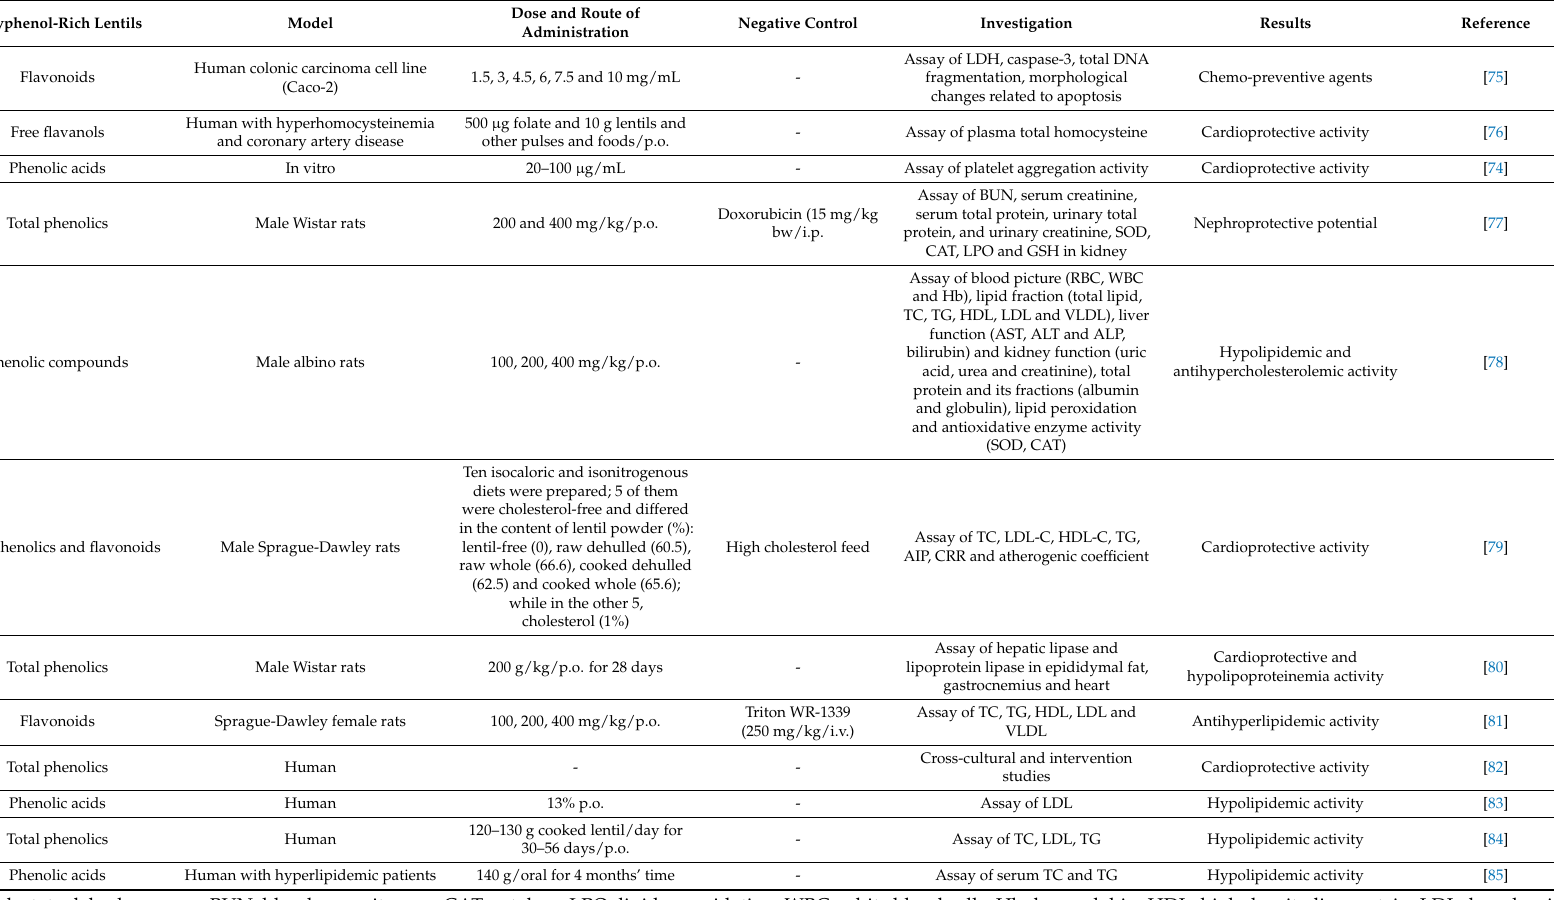
Table 6. Summary of in vitro, in vivo, clinical and intervention/observational studies on the anti-obesity and cardioprotective potentials of polyphenol-rich lentils. Polyphenol-Rich Lentils